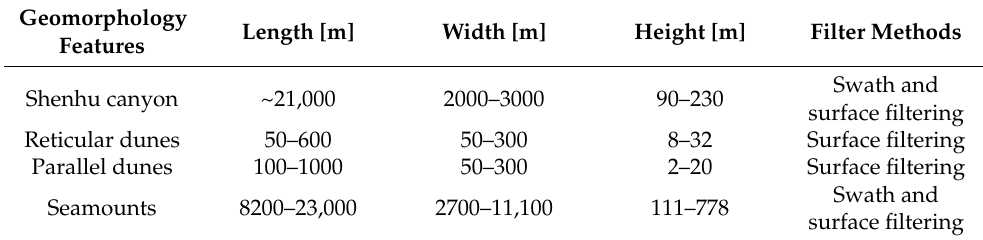
Table 2. Seabed geomorphology scales and the optimal filtering methods.